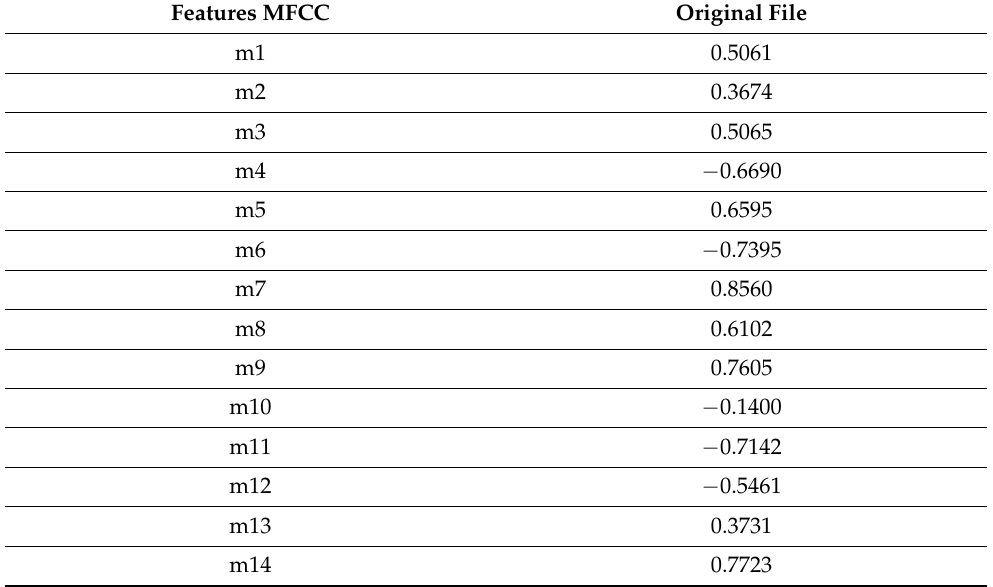
Table 2. Correlation between MFCC features and the number of milling layers.